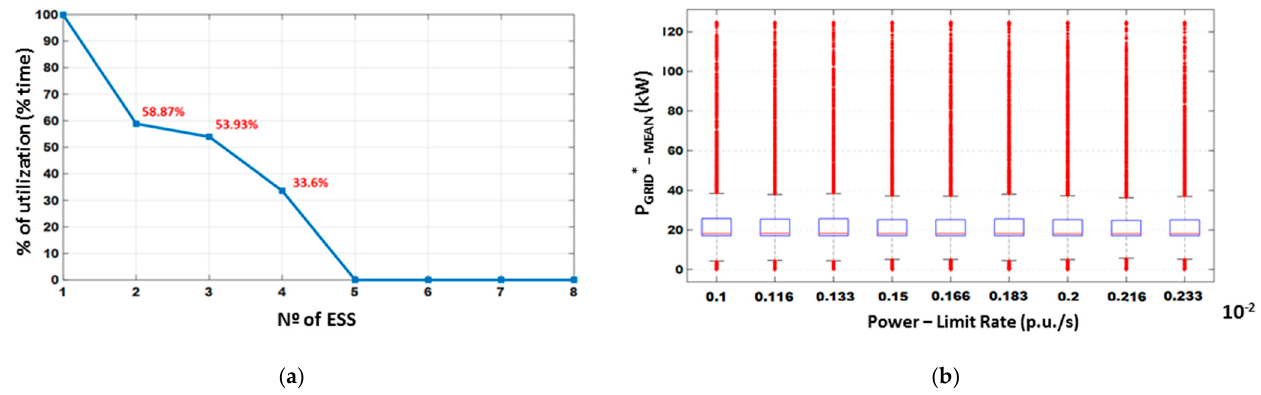
Figure 16. ( a ) Percentage of use of each of the four SC cabinets during the entire period studied and ( b ) box and whisker plot showing the average reference power values that will be delivered to the grid based on different active power ramp rate limits per minute (p.u./s).